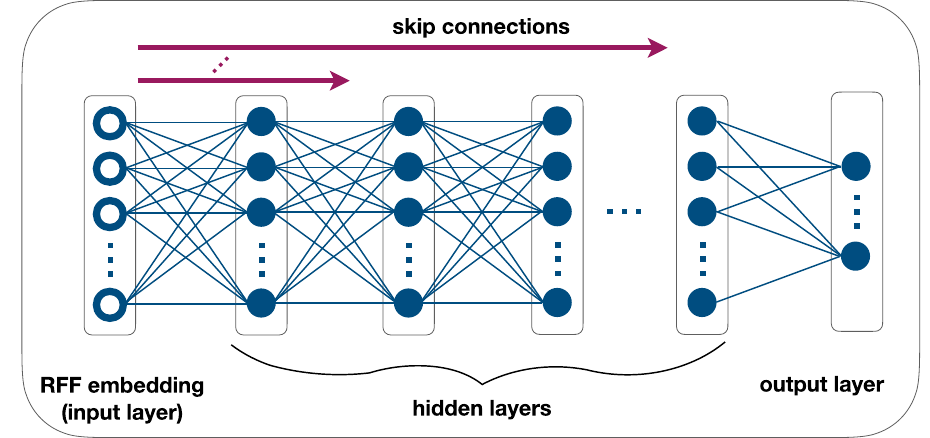
Figure 3. Trainable MLP representing the flux-gradient function. The first layer embeds the input features via Random Fourier Features (RFFs) which are then fed to the first hidden layer. The number of RFFs is the same as the number of hidden units which is constant across the hidden layers. Nonlinearity is introduced by application of a ReLU activation function to the affine mapping returned by the hidden units. The RFF embeddings are also fed to every other hidden layer except the last through skip connections. The output layer consists of as many regression units as the gradient components without activation